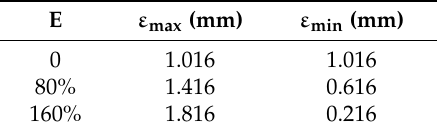
Table 2. The maximum and minimum clearance for di ff erent